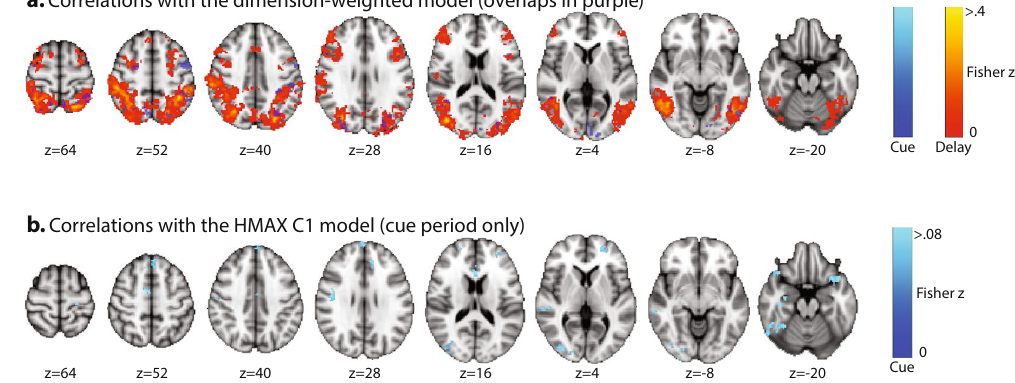
a. Correlations with the dimension-weighted model (overlaps in purple)